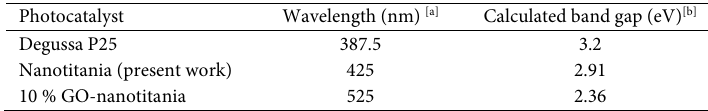
Table 2. Band gap energy values for the photocatalysts Table 2: Band gap energy values for the